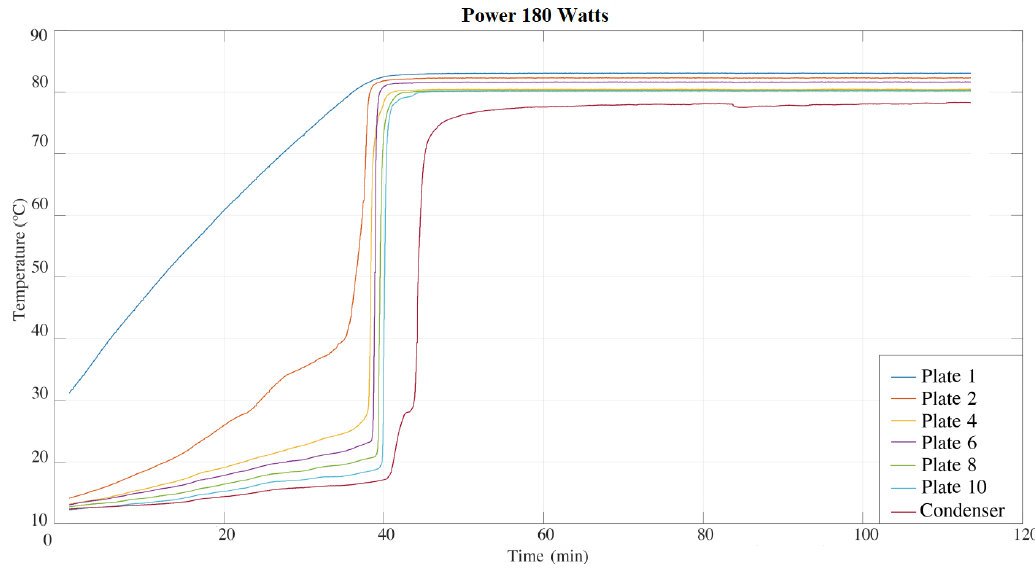
Figure 20. Thermal behavior of the distillation column using the regulated power